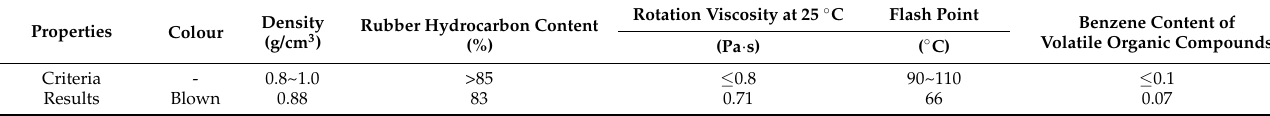
Table 2. SMC normal temperature asphalt modifier properties.